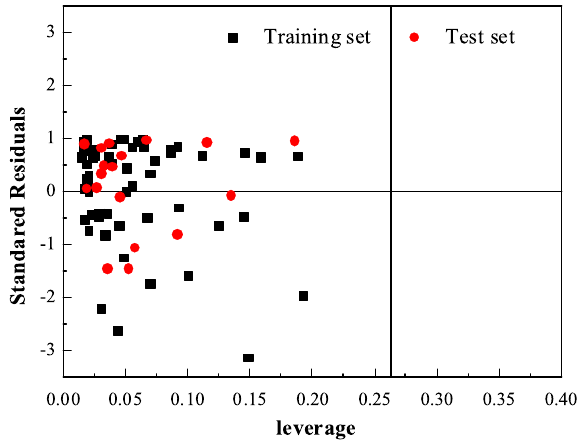
Figure 4. The plot of standardized residuals vs leverage, with a warning leverage of h* =